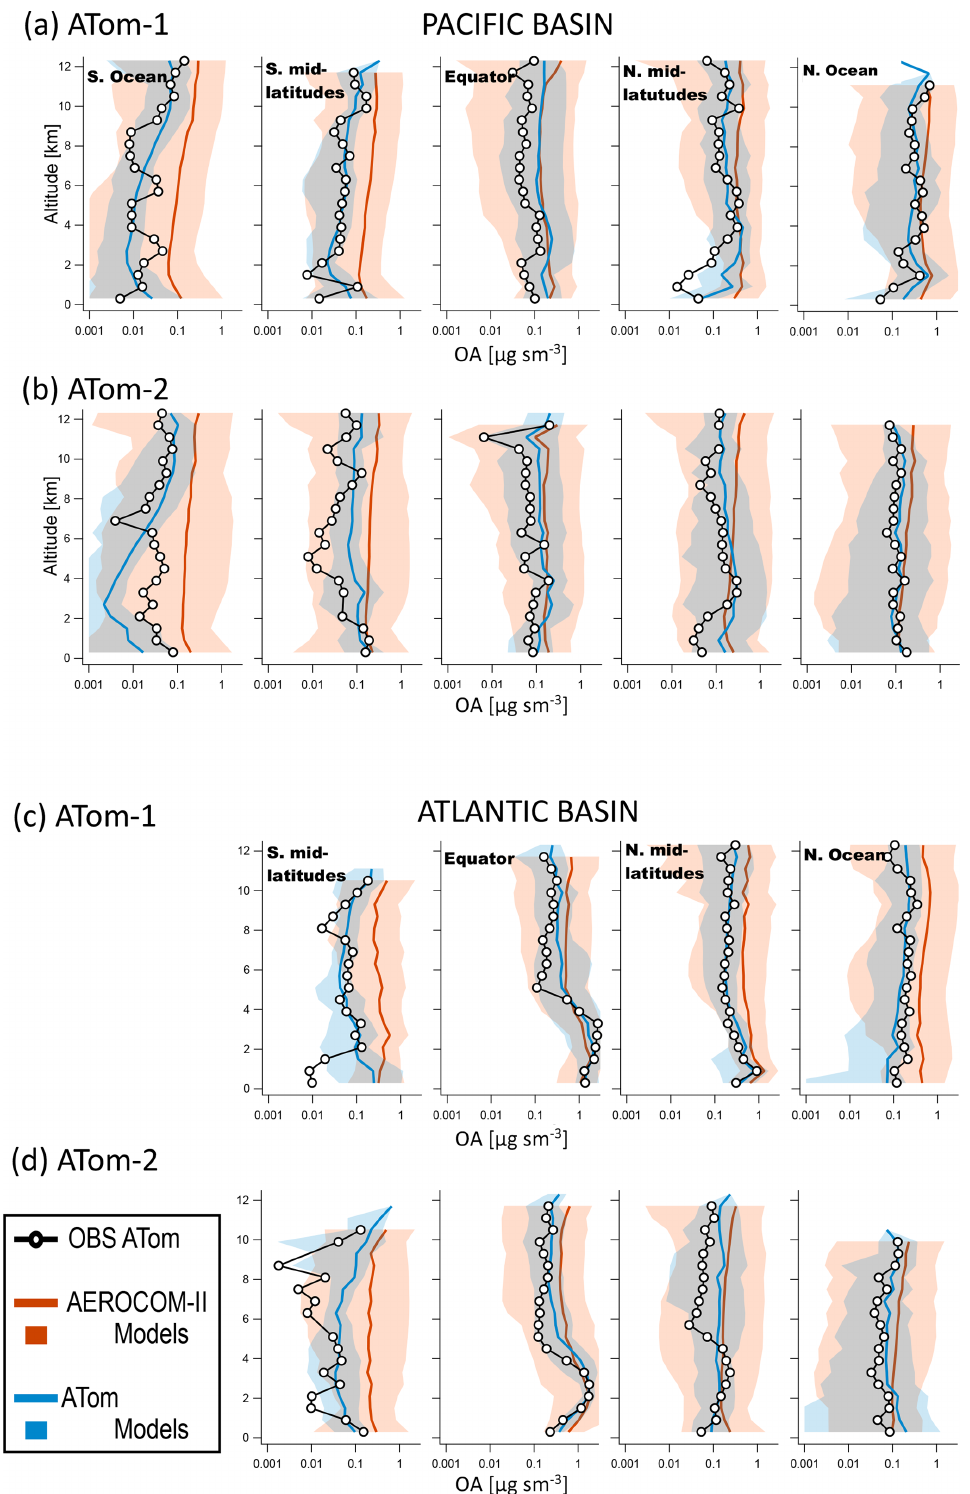
Figure 4. Comparison of latitude-averaged predicted OA vertical profiles with ATom-1 and ATom-2 measurements taken over the Pacific (a, b) and Atlantic (c, d) basins. Results of the AeroCom-II model ensemble average are shown in red, while those of the ATom model ensemble are shown in blue. Shaded areas indicate the variability (2 standard deviations) within each model